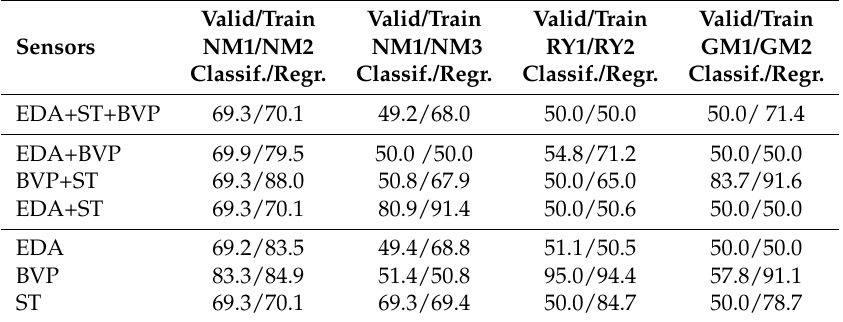
Table 7. Recognition rates of users NM, RY, and GM using models trained using personal data.